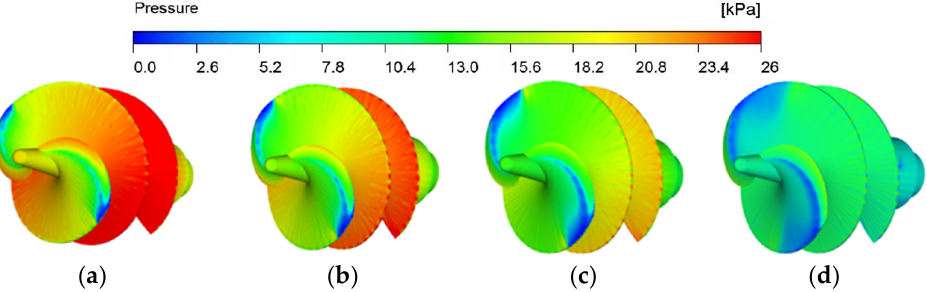
Figure 6. Static pressure distributions in the inducer: ( a ) NPSHa = 1.67 m; ( b ) NPSHa = 1.32 m; ( c ) NPSHa = 1.05 m; ( d ) NPSHa = 0.65 m.